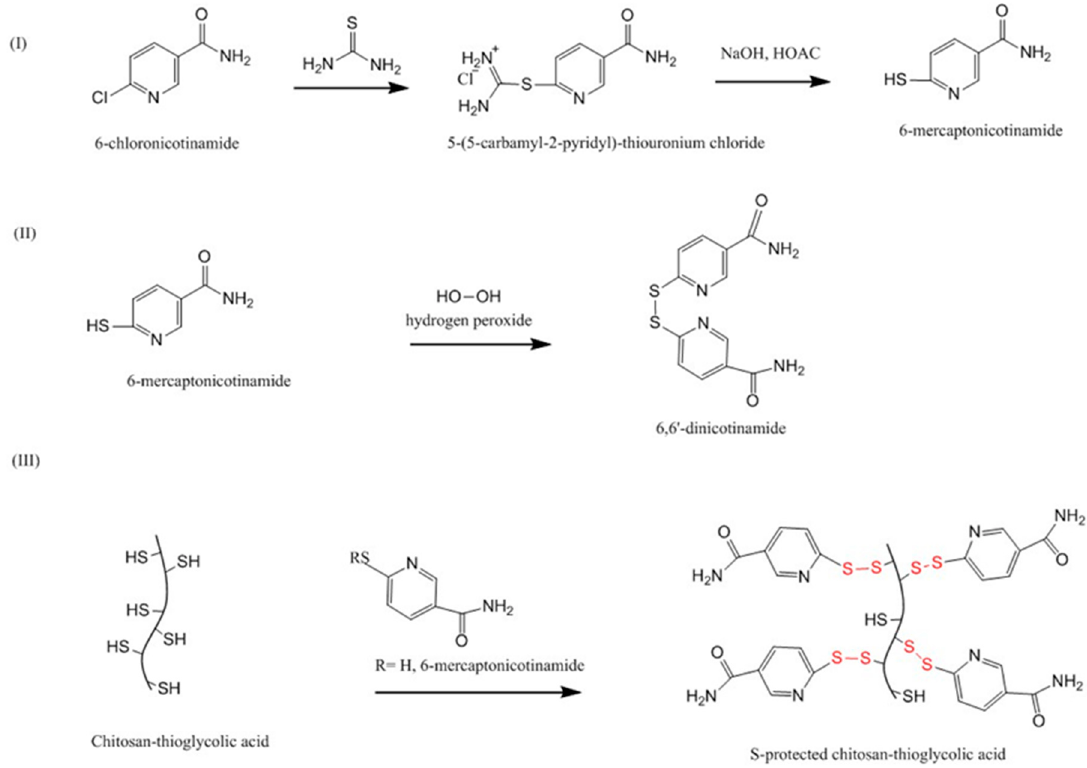
Figure 10. Synthetic pathway to S-protected chitosan-thioglycolic acid [111].